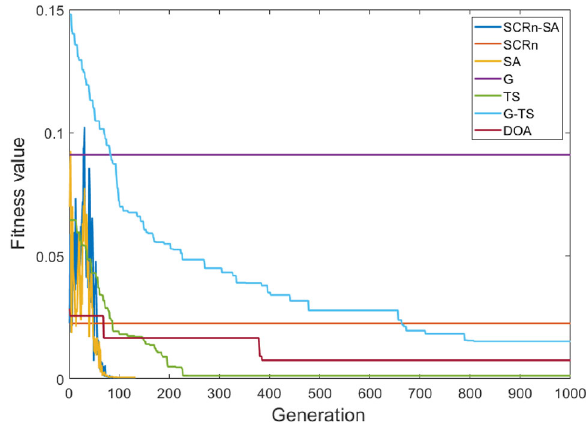
Fig. 4 Convergence curve for f 7